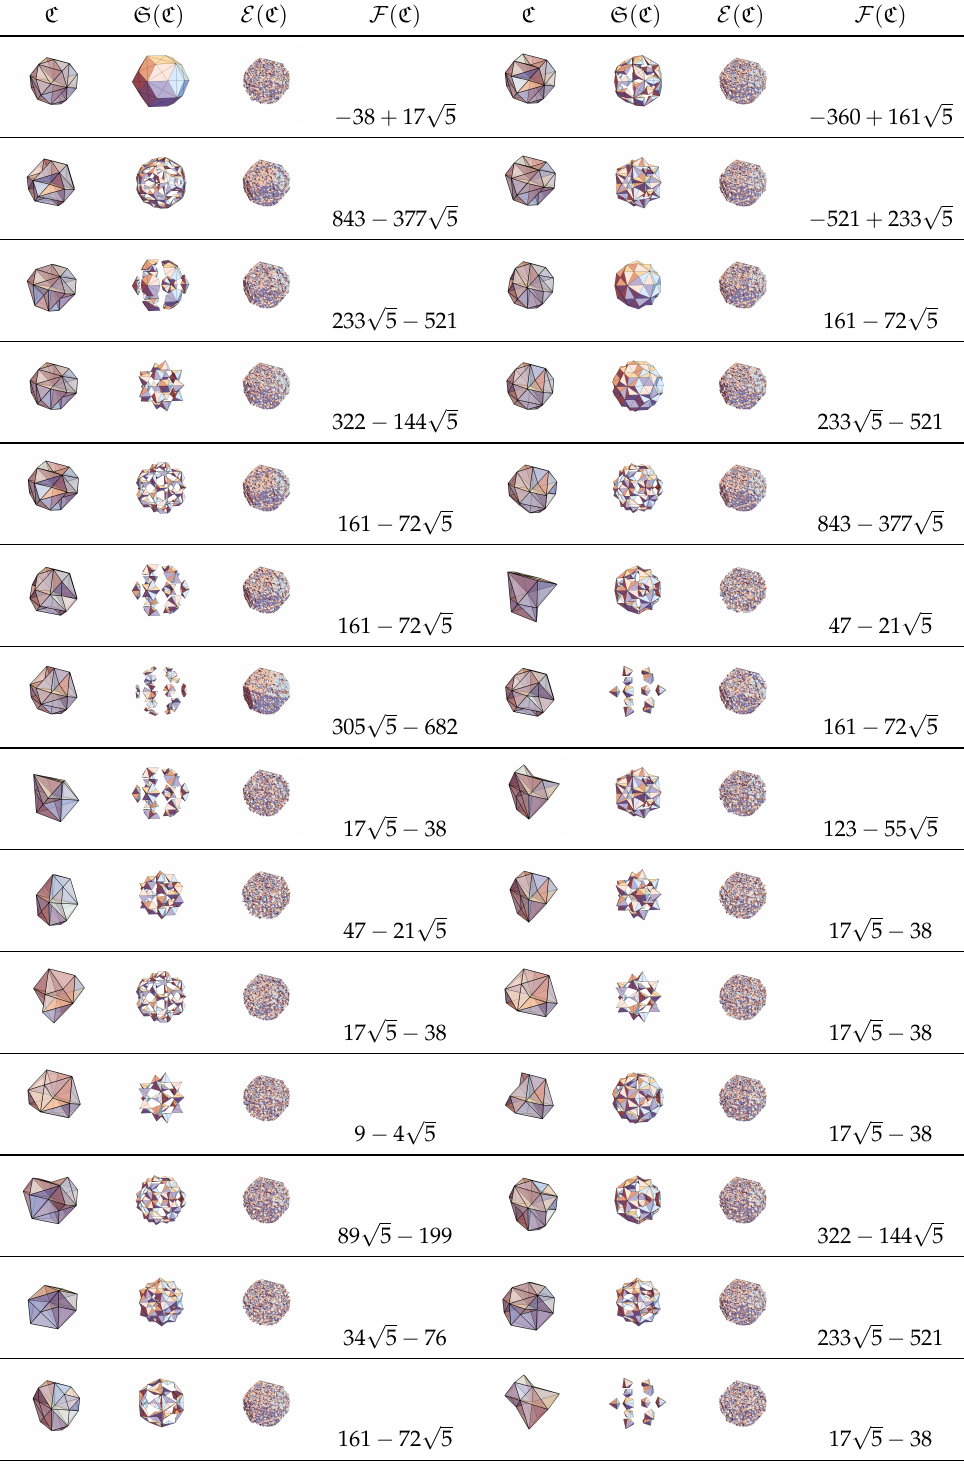
Table 1. The 36 vertex configurations C for the tiling T ( D 6 ) are shown along with their corresponding cut-window sectors s ( C ) , their empires E ( C ) , and their frequencies F ( C )